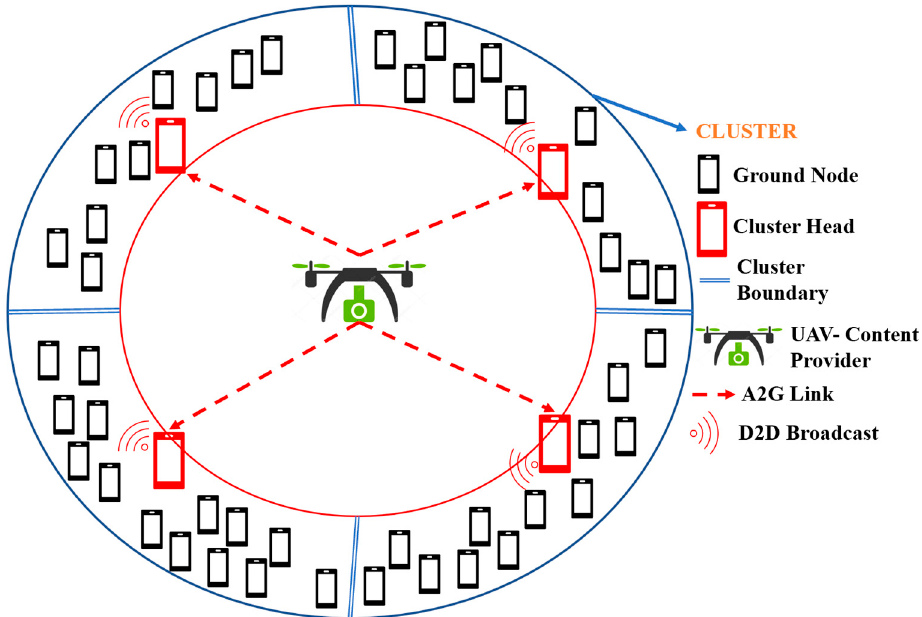
Figure 2. The system model considers a social event such as a football stadium. Ground nodes (users) are distributed in the stadium stands. The proposed scheme considers forming clusters, where each cluster is represented by a cluster head (shown as a red node in the figure). UAV-BS is the content provider, which directs them to the cluster head. Cluster heads then forward the contents to their cluster members using D2D links. The link between the UAV and cluster head is denoted by the air-to-ground (A2G) link, represented by a red dotted line.